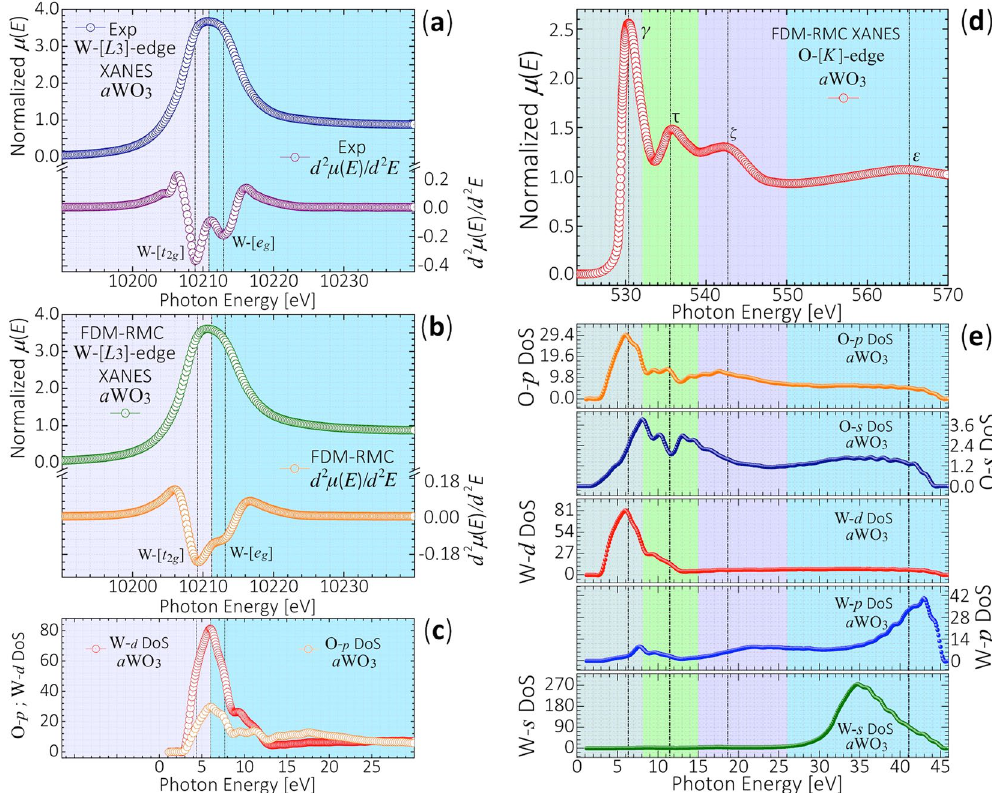
Figure 5. Normalized W- L 3 -edge and O- K -edge XANES spectra of a WO 3 . ( a ) Normalized experimental W- L 3 - edge XANES spectrum of a WO 3 , and its second derivative µ d E d E ( )/ 2 2 . ( b ) Ab - initio FDM computed W- L 3 -edge XANES spectrum from RMC-EXAFS optimized structures of a WO 3 , and its second derivative µ d E d E ( )/ 2 2 . The spectrum exhibits absorption maxima associated to electronic transitions of the photoelectron from the initial W-[2 p 3/2 ] orbitals to the final unoccupied W-[5 d ]-O-[2 p ] hybridized CB states. From the relative energy separation of the W-[ t 2 g ] and W-[ e g ] bands in the second derivative µ d E d E ( )/ 2 2 of the W- L 3 -edge XANES spectra, a crystal field splitting Δ d ≈ E ( e g ) − E ( t 2 g ) ≈ 4.0 ± 0.2 eV is found. ( c ) Contribution of the W-[5 d ] and O-[2 p ] projected DoS to the W- L 3 -edge XANES spectrum of a WO 3 . ( d ) Ab - initio FDM calculated O- K -edge XANES spectrum of a WO 3 , as computed from its RMC-EXAFS optimized structures. The spectrum is due to electronic transitions from the O-[1 s ] core-level into unoccupied O-[2 p ] orbitals. ( e ) Contribution of the W-[ s , p , d ] and O-[ s , p ] projected DoS to the calculated O- K -edge XANES spectrum of a WO 3